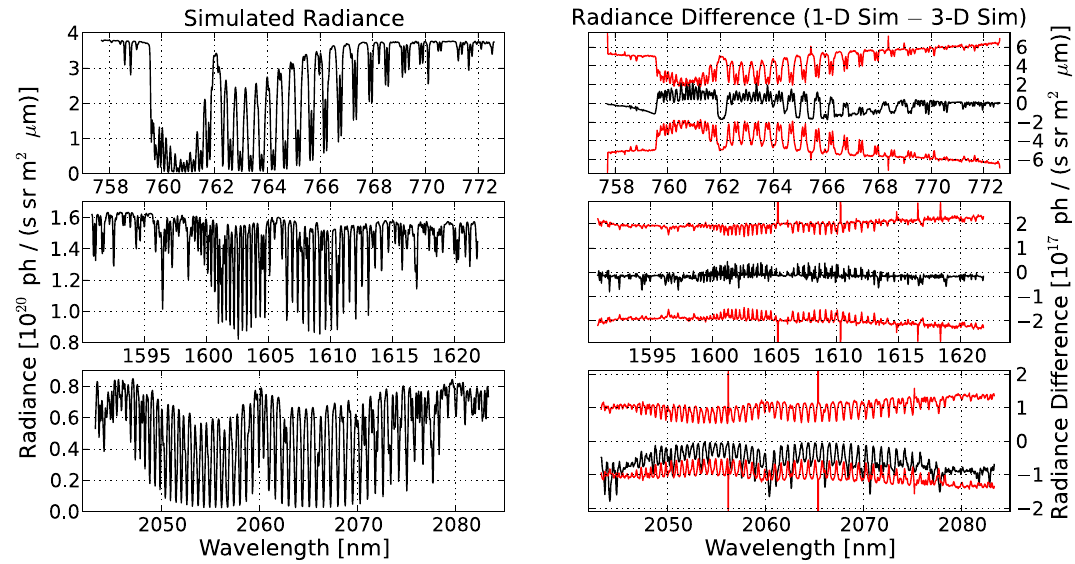
Figure 1. Comparing simulated radiance spectra for a clear atmosphere column using the 1-D OCO-2 simulator and the 3-D SHDOM-based OCO-2 simulator. The left column shows the simulated radiance for each band, and the right column shows the radiance differences (1-D minus 3-D simulated spectra), with the ± 1 σ sensor noise level envelope overplotted with red lines. Note the y axis units for the plots in the left column are a factor of 10 3 larger than the units on the right column.